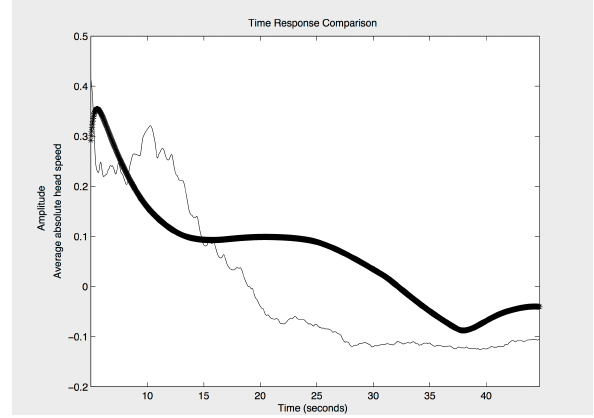
Figure 7. Original output and the output of the LTI model